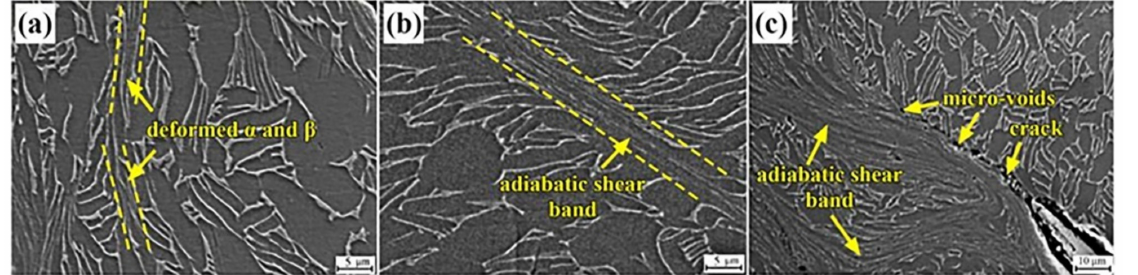
Figure 11. The SEM graphs of the adiabatic shear band in the DM sample under the strain rate of 3000 s − 1 : ( a ) initiation area; ( b ) expansion area; ( c ) fracture